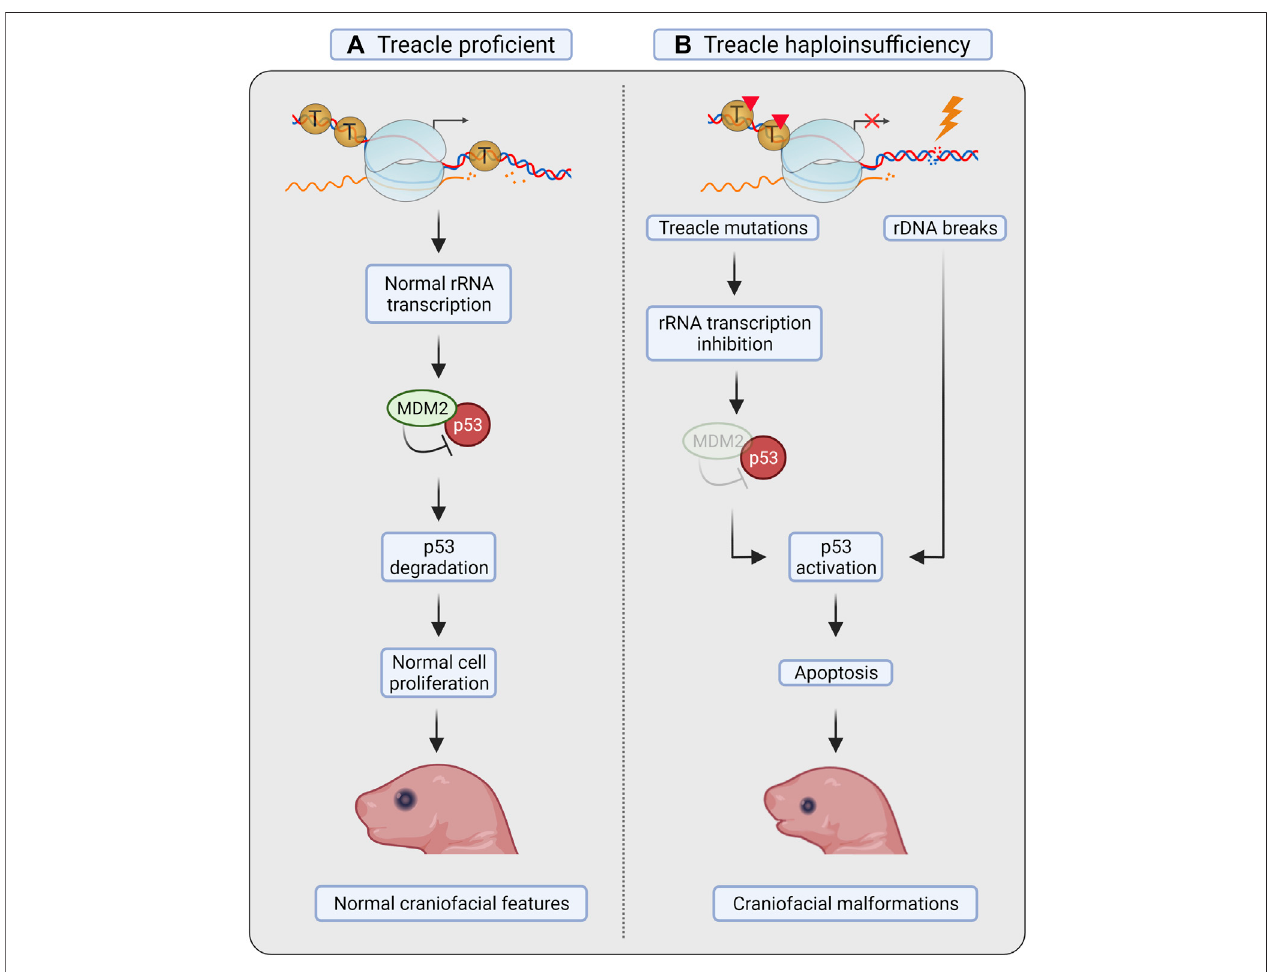
FIGURE 3 | Treacle in Treacher Collins syndrome. (A) Treacle pro fi cient mice show normal rRNA transcription, proliferation and apoptosis in neural crest cells (NCC), and develop normal craniofacial features. (B) Inmice withTreacle haploinsuf fi ciency( tcof1 +/ – ),however,increasedapoptosis wasobserved inNCC. Mutations in Treacle compromise rRNA transcription, leading to ribosomal protein-mediated sequestration of MDM2, and consequent p53 stabilization. Increased rDNA damage in the absence of Treacle-mediated repair can also facilitate p53 stabilization. Activation of p53 leads to increased apoptosis of NCC and to the development of craniofacial malformations. Created with